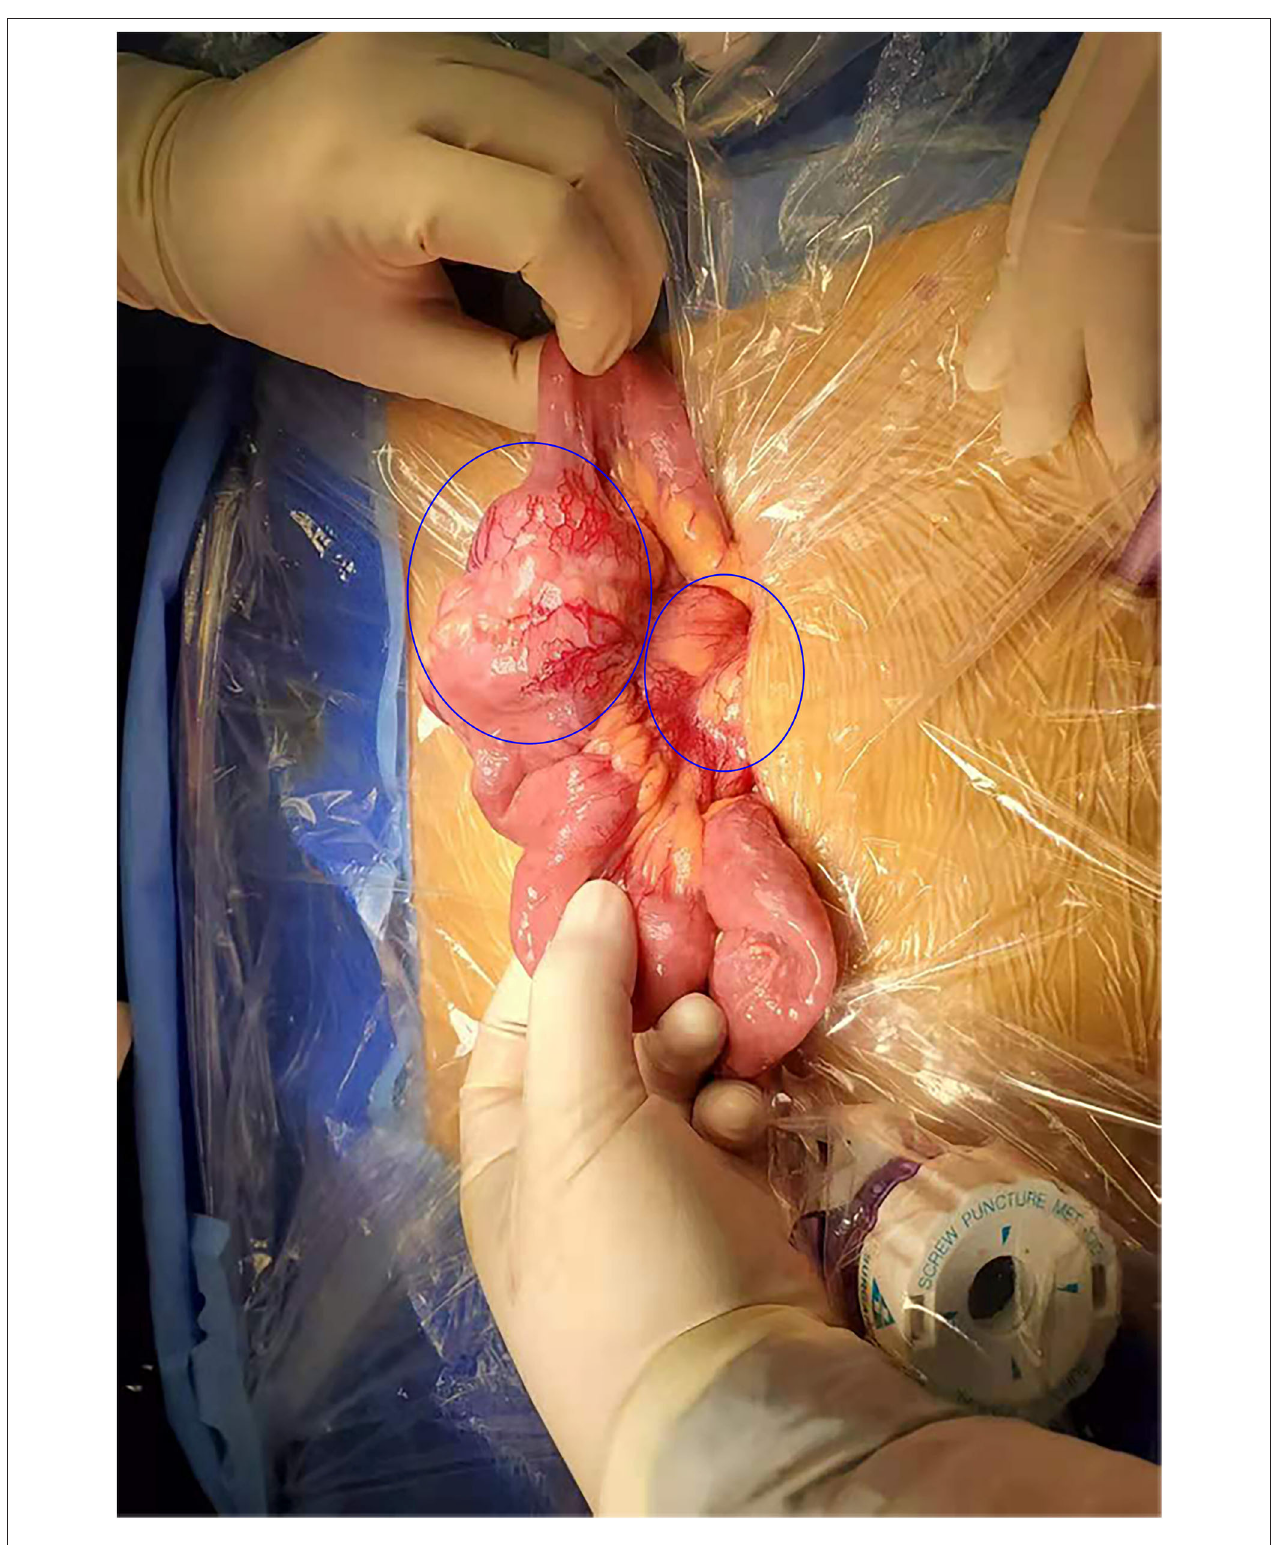
FIGURE 2 | Surgical findings. Enlarged lymph nodes were identified in the root of the mesentery in addition to the mass tumor in the small intestine.